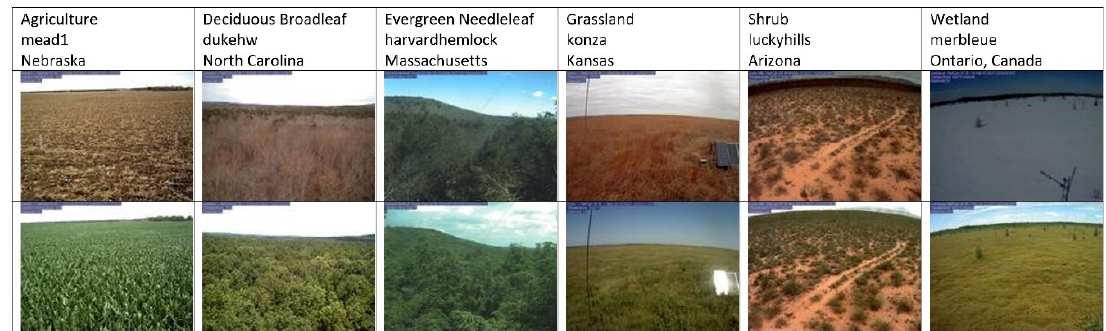
Figure 1. Locations of the 92 sites used in this study. Remote Sens. 2020 , 12 , x FOR PEER REVIEW